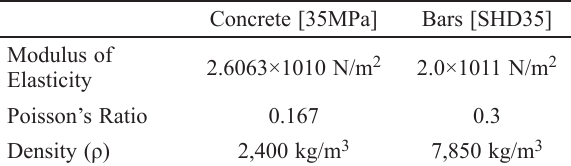
(b) Inserted curved parts in X-braced bars